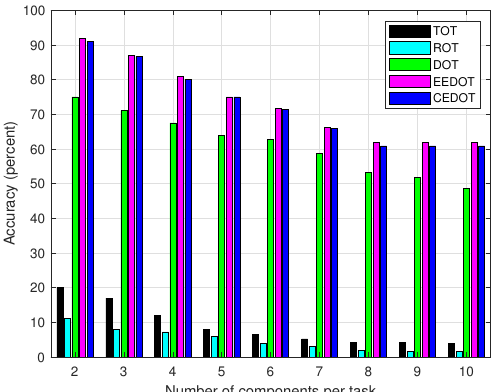
Figure 6. DNN accuracey for different number of components per task.